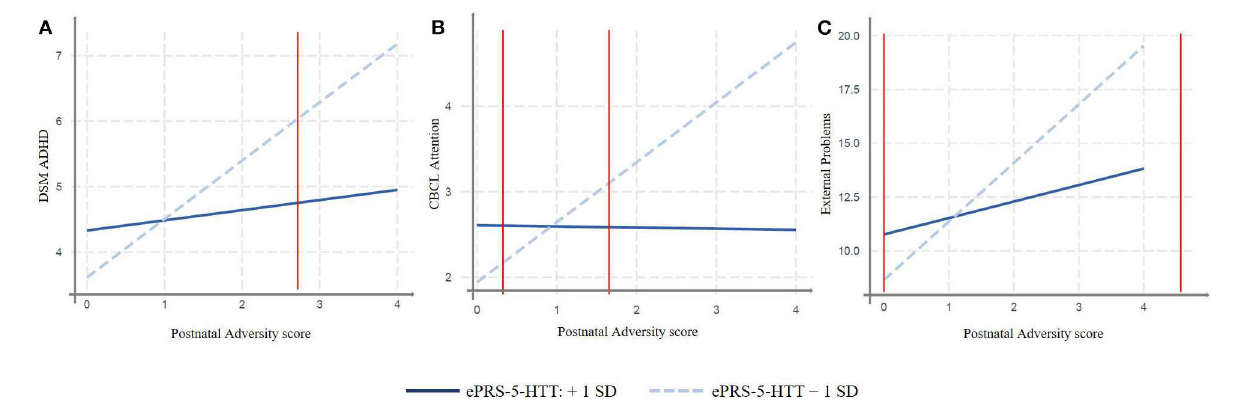
FIGURE 3 | Interaction effect between Postnatal Adversity Score and amygdala-based ePRS-5-HTT on: (A) ADHD problems at 4 years, (B) attention problems at 4 years, and (C) Externalizing Problems at 4 years. Increased postnatal adversity exposure is associated with outcomes related to more Behavioral problems as ePRS decreases. GUSTO cohort, N =